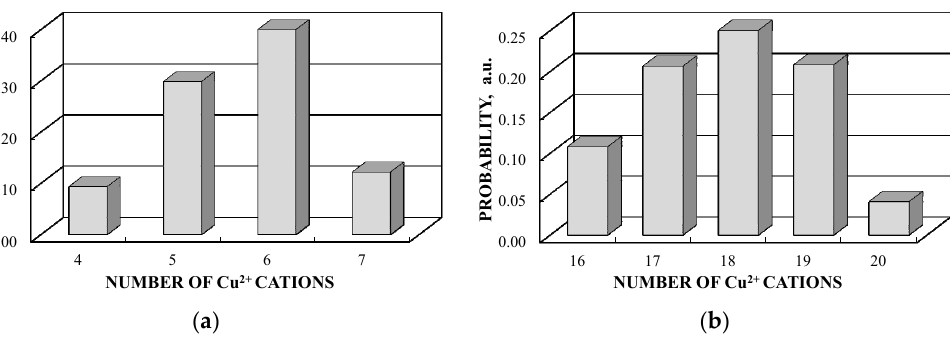
Figure 65. Histograms of the probabilities of different numbers of Cu 2+ cations (total in the (A) and [B] sites) in the local microenvironments of Fe 3+ A ( a ) and Fe 3+ B ( b ) cations within the coordination sphere of 3.7 Å in the ideal CuFe 2 O 4 crystal with one Cu 2+ cation in the (A) sites. These histograms of the probabilities of different numbers of Cu 2+ cations in the local microenvironments of Fe 3+ A and Fe 3+ B demonstrate four and five reliable different num ‐ bers of Cu 2+ , respectively. This result may confirm decomposition of the Mössbauer spectra of CuFe 2 O 4 nanoparticles and the (CuFe 2 O 4 ) 0.99 (SnO 2 ) 0.01 nanocomposite with four magnetic sextets assigned to 57 Fe in the (A) sites and six magnetic sextets associated with 57 Fe in the [B] sites (see Figures 62 and 63).